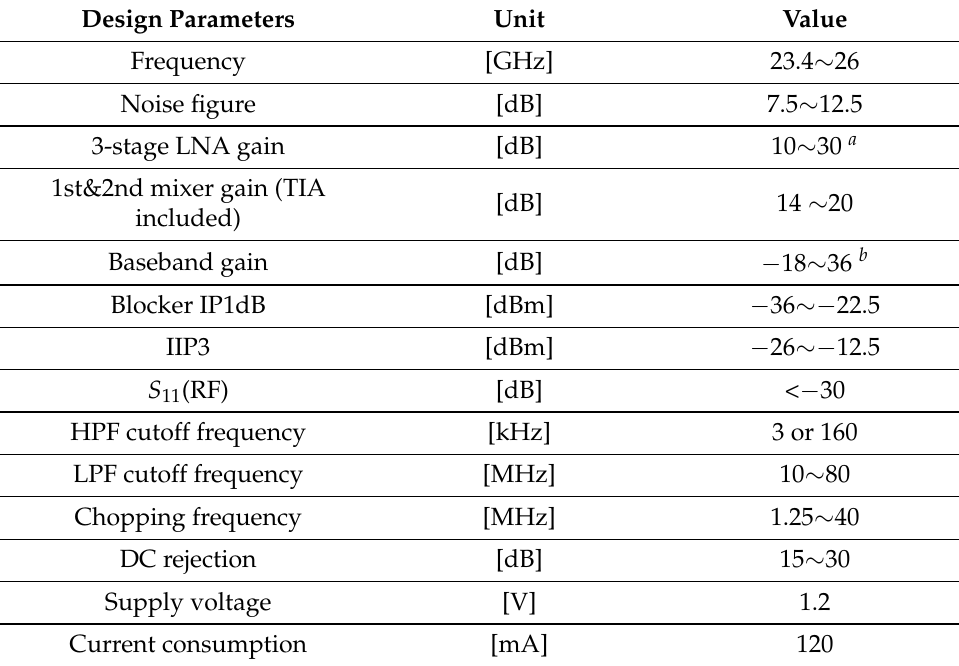
Table 4. Receiver design